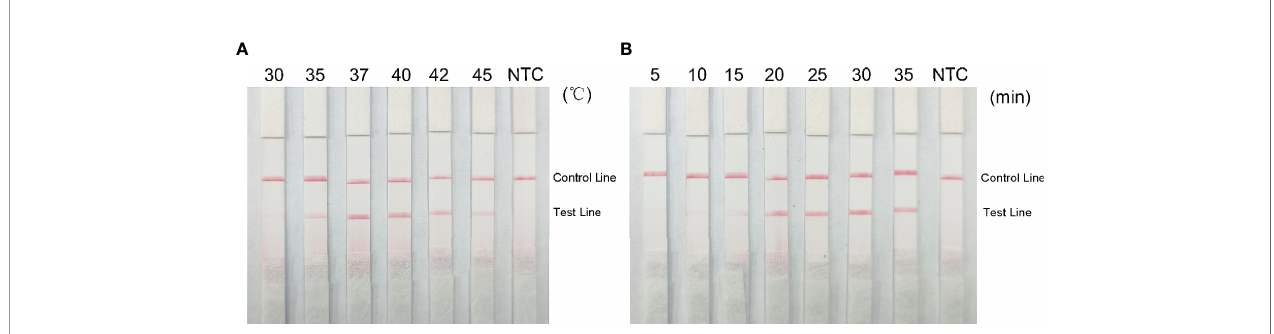
FIGURE 7 | Optimalreactiontemperatureandtime for theRPA-LFSsystem. (A) Imagesshow theLFS resultsofRPAampli fi cationatdifferenttemperatures.Thetemperatureat whichtheRPAreactionwas performedisshownatthetopofeachband. Thetemplateis thesupernatant obtainedfrom the boiling methodofKlebsiellapneumoniaecarrying rmpA2. The NTCstripwasperformedat37°C withouttemplatecontrol. (B) Images showtheresultsofLFSfor differentlengthsofRPAampli fi cation.Thelengthoftime toperform theRPAreactionisshownatthetopofeachstrip.ThetemplateisthesupernatantobtainedfromtheKlebsiellapneumoniaecookingmethodcarryingrmpA2.TheNTC stripwas performedfor30minuteswithout templatecontrol. Thepositionsofthecontrolandtestlinesareshownonthe rightsideoftheimage.